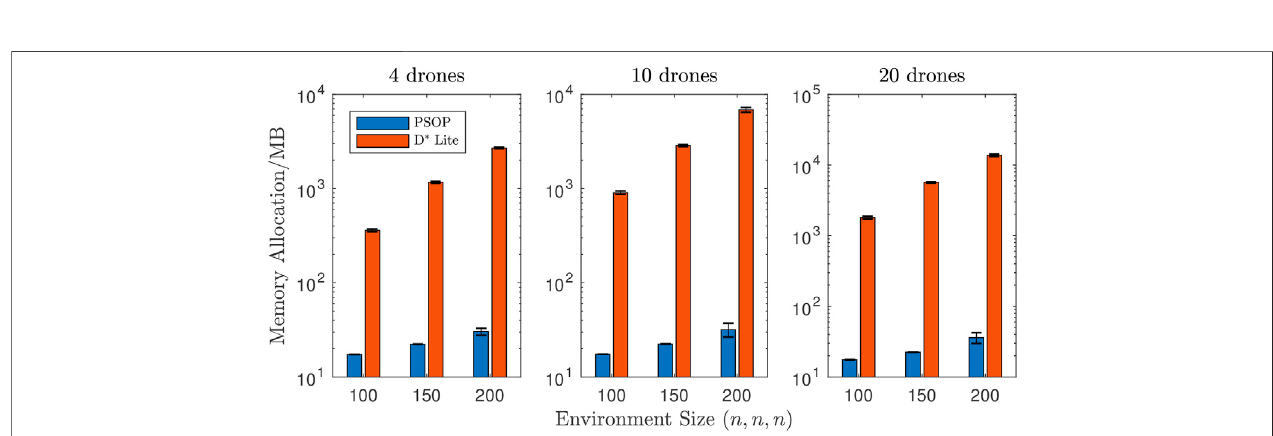
FIGURE 5 | Weighted mean memory allocation by environment size. Across all nine scenarios, p-drones were shown to require far lower memory allocation than d-drones.For4dronestheresultsshowafarhighermemoryallocation,whichincreasesmorerapidlyastheenvironmentsizeincreases,whenusingD*Lite.Thistrendis increasingly enhanced for 10 and 20